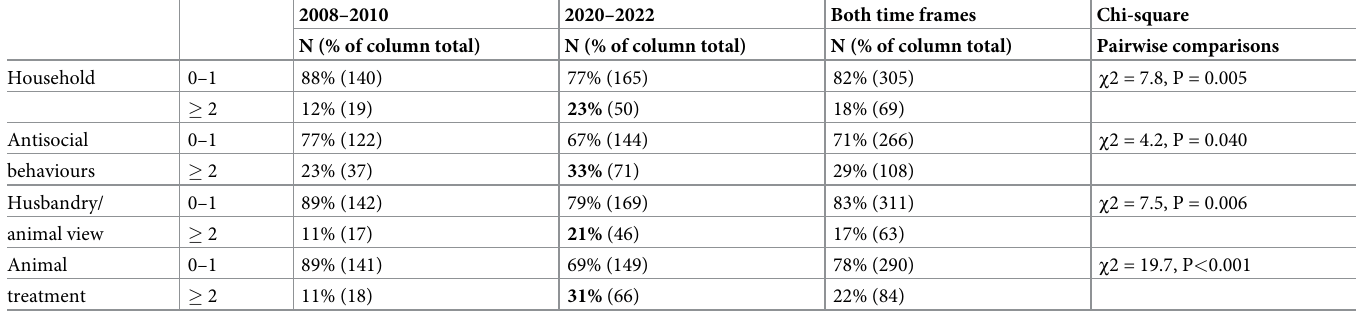
Table 10. Multifactorial situation within four categories of dog ownership factors applying to 374 cases of dogs confiscated for human-/ animal-directed biting inci- dents. We present percentages of cases (and counts between brackets) that a dog ownership factors within the categories of owner household, owner antisocial behaviours, husbandry/ animal view and animal treatment was reported on as a multifactorial situation ( � 2 factors within a category applying to a case) for a first time frame (2008– 2010), a second time frame (2020-mid-May 2022) and overall for both time frames. Pearson Chi-square values are indicated for significant differences in pairwise compari- sons between the two time frames, per factor (P < 0.05, df =